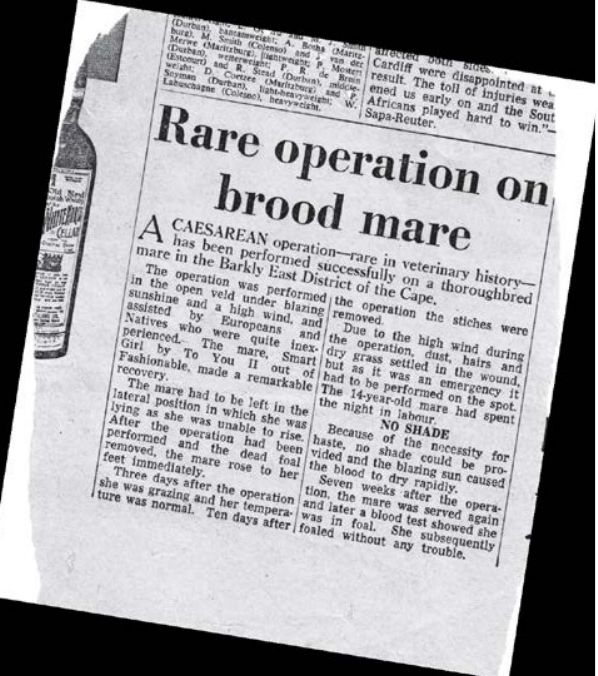
Figure 6: A newspaper article describing the